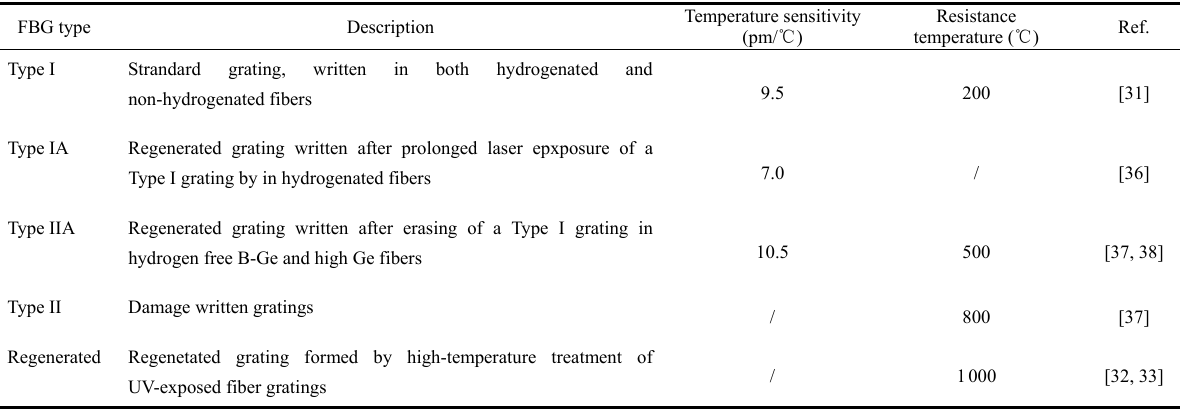
Table 2 Temperature characteristic comparison of normal FBG